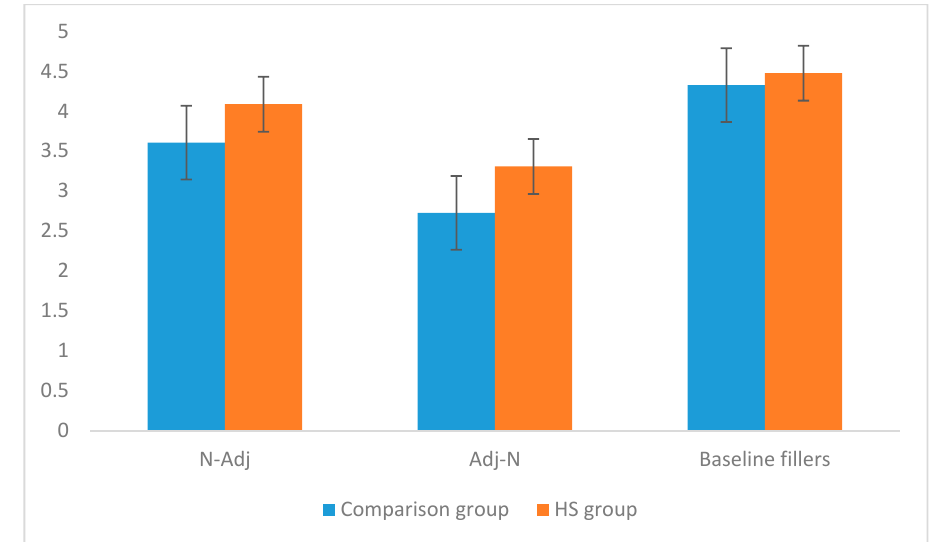
Figure 1. Average ratings for N-Adj, Adj-N and baseline fillers by group.